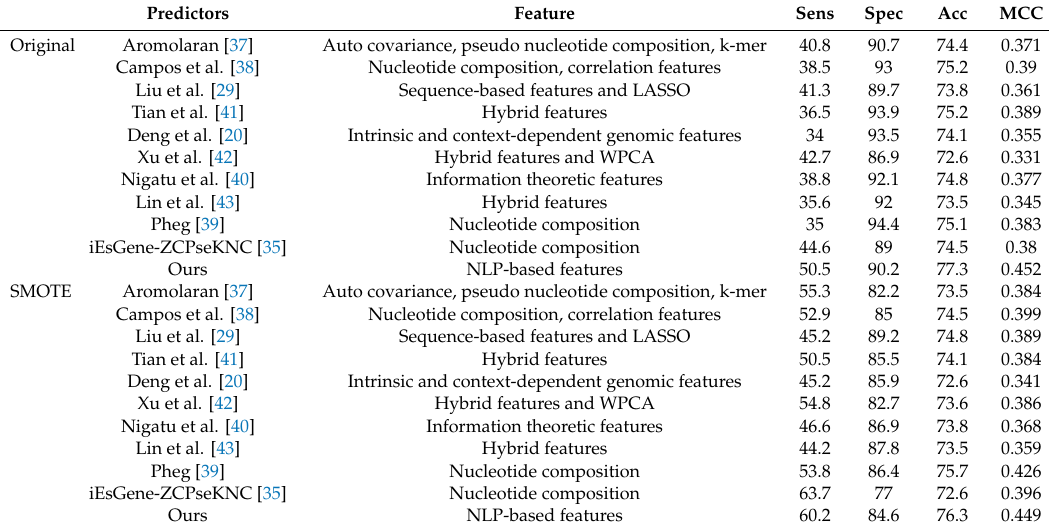
Table 4. Prediction of essential genes using di ff erent state-of-the-art predictors. SMOTE: syntactic minority over-sampling technique; NLP: natural language processing; LASSO: least absolute shrinkage and selection operator; WPCA: weighted principal component